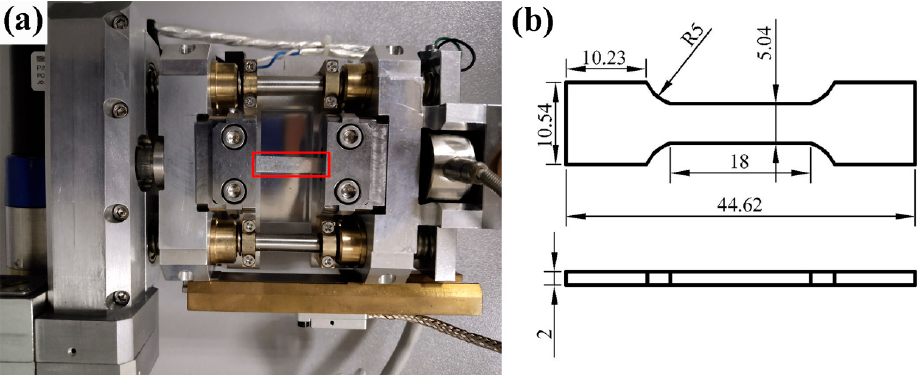
Figure 1. ( a ) In situ tensile testing system. ( b ) The machined size of the in situ tensile specimen (unit: mm).